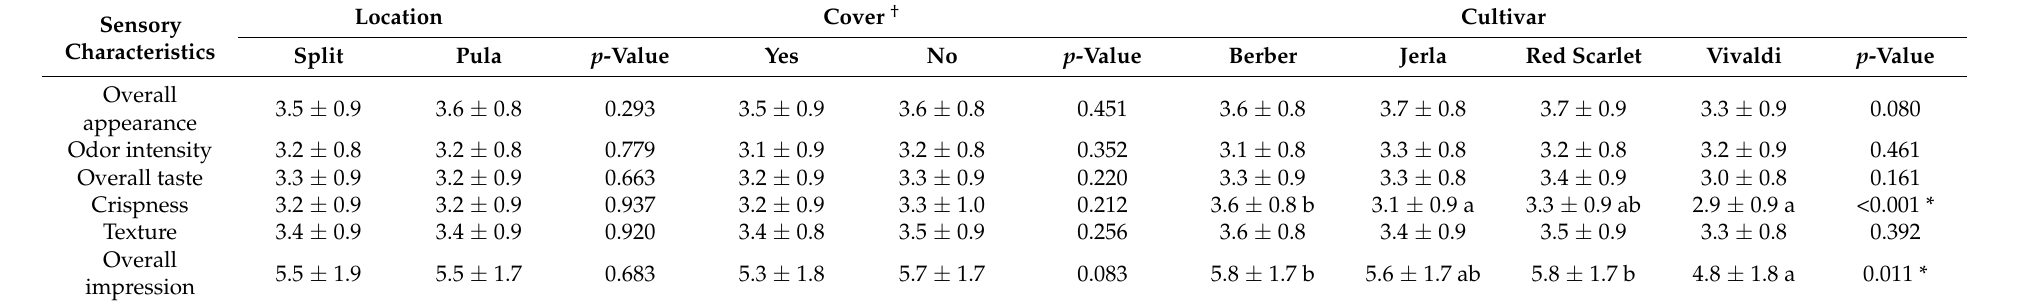
Table 6. Sensory characteristics of potato tubers affected by location, plant cover and cultivar in the second